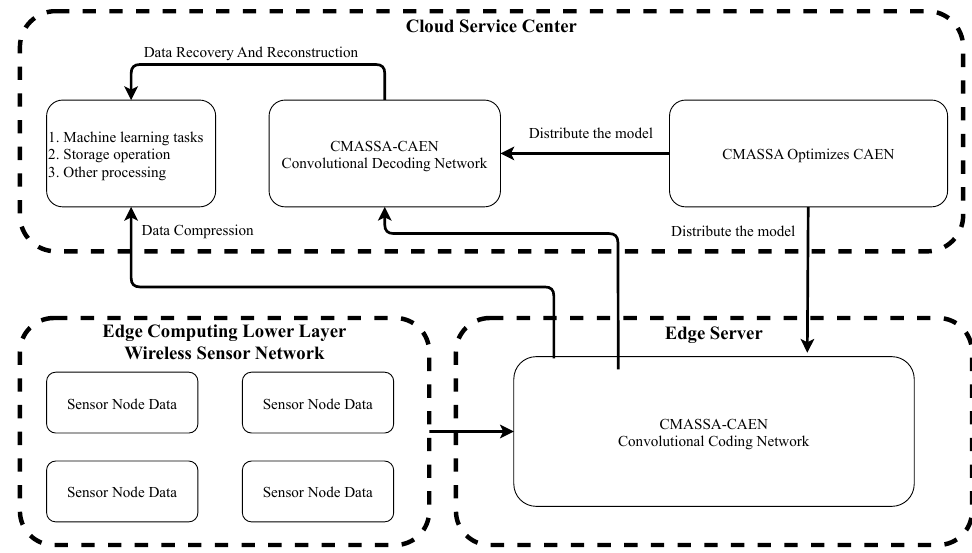
Figure 5. Cloud edge data compression model